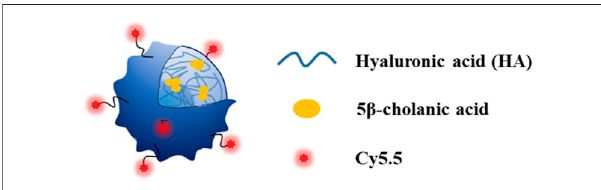
FIGURE5| Conjugationofhydrophobic5-cholanicacidwithhyaluronan resulted in self-assembled nanoparticle formation. This formulation could be a drug carrier for atherosclerotic plaques imaging and/or therapy (Copyright permission from Elsevier).